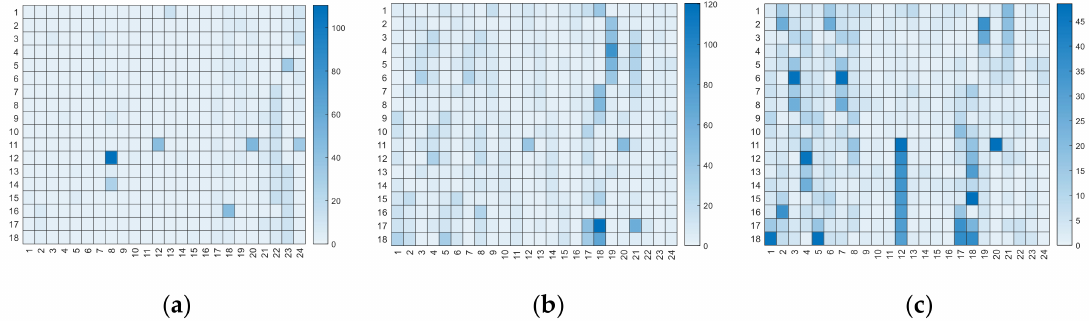
Figure 13. Comparison of error for simulation results: ( a ) error of simulation results with decision tree, ( b ) error of simulation results with NARX, ( c ) error of simulation results with